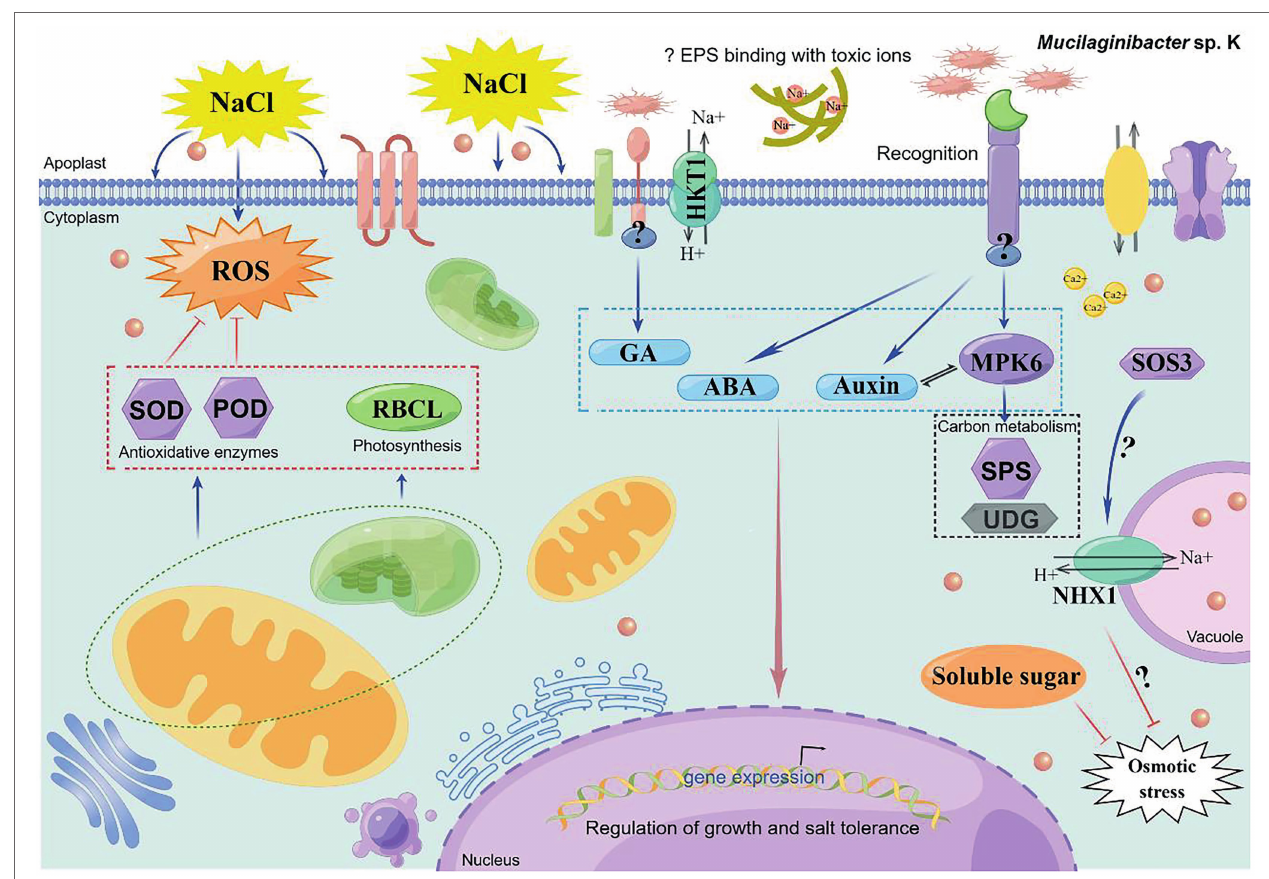
FIGURE 10 | A schematic proposed model of Mucilaginibacter sp. K-mediated salt tolerance in plants [drawn by Figdraw (www.figdraw.com)]. Based on the results from current study, we propose that stain K participates in salt tolerance through activating the GA- and auxin-dependent signaling pathways, which might lead to concurrent expression of genes involved in growth promotion and salinity resistance. Strain K colonizes roots and might enhance photosynthesis through upregulation of chlorophyll content and transcription of RBCL . Strain K induces Na + efflux and sequestration to lower ion cytotoxicity. Strain K also enhances activities of antioxidant enzymes such as POD and SOD and soluble sugar content in strain K-treated plants, contributing to reduced ROS degradation and osmotic stress, respectively. Strain K promotes ABA accumulation, which might play a role in the activation of SOS3 through Ca 2+ flux. Specifically, the growth promotion and salt tolerance conferred by strain K is dependent on MPK6 signaling, which function in regulating ROS homeostasis, ionic homeostasis, and plant growth and development. As downstream targets of MPK6, SPS, and UDG are also positively influenced by strain K in salt-stressed plant, probably leading to enhanced cell growth. ABA signaling might form complex cross-talks with GA, auxin, and MPK6 to modulate strain K-mediated salt stress responses in plants, leading to an optimal growth under this specific environmental condition. This model may explain how the strain K trigger salt tolerance when it is root-tip or seed